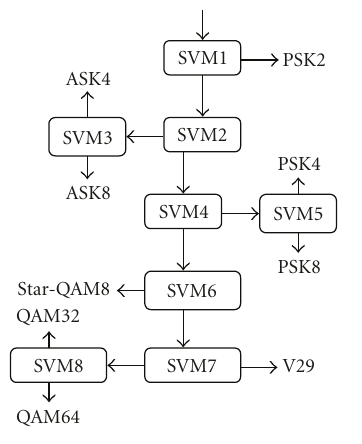
Figure 2: Hierarchical SVM-based